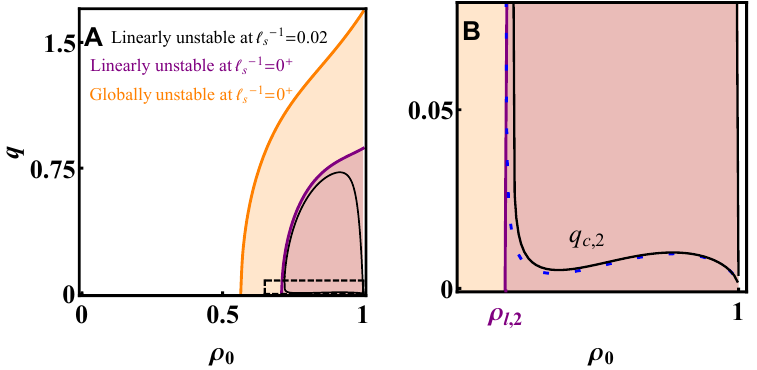
Figure 8: A comparison of the phase diagrams of the DPT in the infinite system-size = 0) and at finite ℓ limit ( ℓ − 1 , at Pe = 3.9 . The region marked by a dashed box s s in panel (A) is shown in panel (B). As in Fig. 4 (C), the regions of linear and global → 0 are shown in purple and orange. The numerically obtained instability for ℓ − 1 s = 0.02 is delimited by region of linear instability for a small but finite value ℓ − 1 s a black curve. The dashed blue line in panel (B) is the analytical expression (38) which is valid at first order for small ℓ − 1 , and is in good agreement with the previous s numerical results. These curves illustrate the boundary layer described in the main